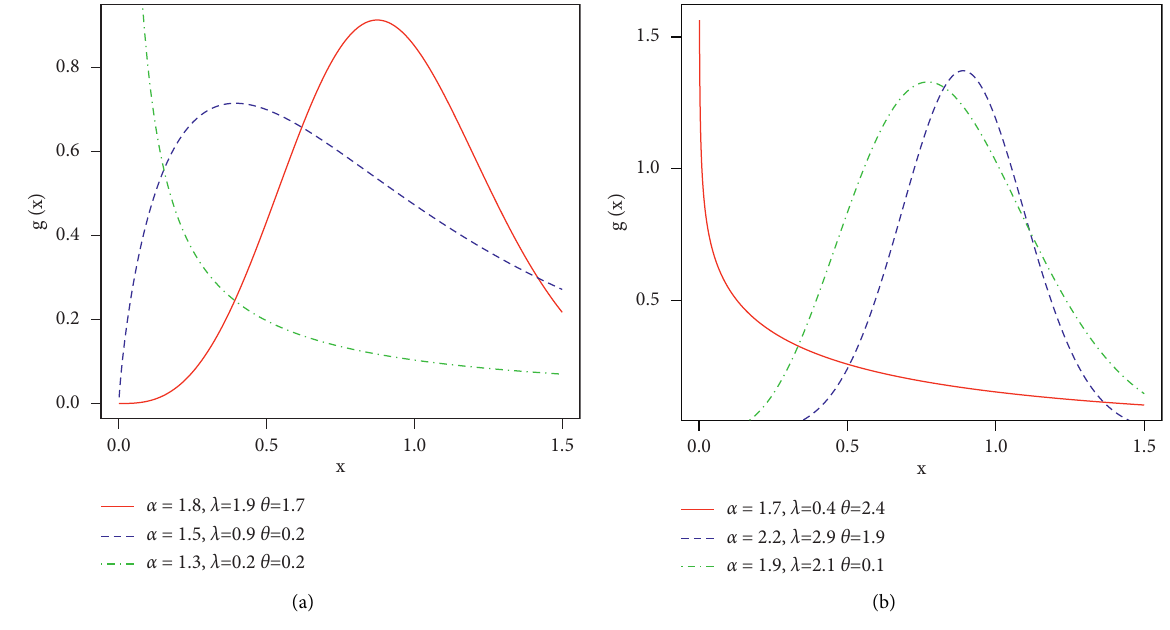
Figure 1: Plots of the pdf using different values of